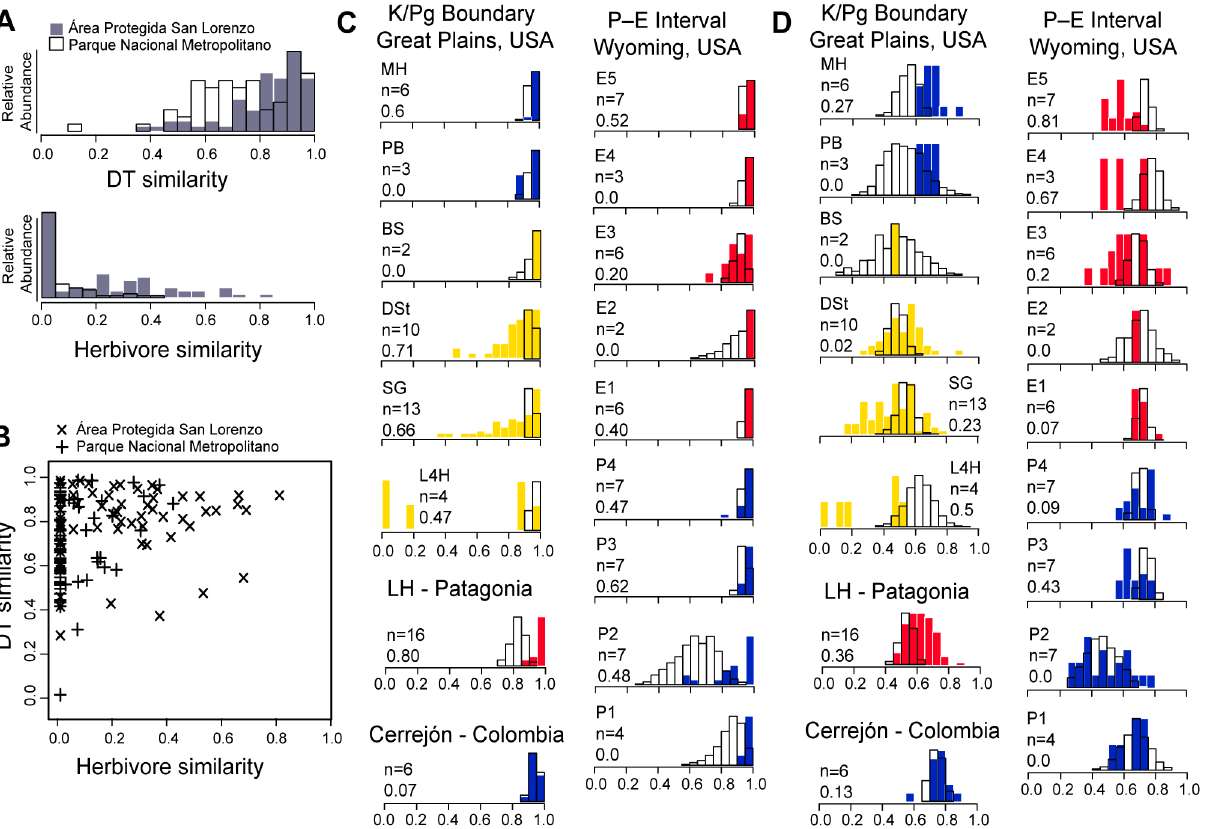
Figure 3. Pairwise host-plant similarities based on herbivores and leaf damage in living forests, and on leaf damage in fossil forests. ( A ) Inverse relations between the distributions of pairwise similarities of leaf damage (DT) and herbivore species, estimated using the Chao- Sørensen index, for host-plant species pairs at the A´rea Protegida de San Lorenzo (gray bars) and Parque Natural Metropolitano (hollow bars), Panama´ (Dataset S1). Vertical axis indicates relative abundance of species pairs showing a given similarity index (horizontal axis). Similarity of DTs between host-plant pairs is much higher than similarity of herbivores, as expected from convergence. ( B ) Plant-species pairwise similarities of herbivores and leaf damage, from the Panama´ crane sites (same as in A ). ( C ) Skewed distributions of host-plant pairwise similarities of leaf-chewing damage at fossil sites (see Materials and Methods), estimated for (n) species at each fossil site, using the Chao-Sørensen index (Dataset S1). Axes are similar to those in ( A ). Yellow = Late Cretaceous, blue = Paleocene, and red = Eocene age. Hollow bars represent distributions of the null expectation, and numbers indicate how many host-plant species (n) and the proportion of observed pairwise estimates that fall outside the null distribution range. ( D ) Distributions of host-plant pairwise similarities of total leaf damage (i.e., including endophytic, largely specialized feeding such as mines and galls) at fossil sites as in (C), estimated as 1-Sørensen coefficient (Dataset S1). There is greatly increased distinctiveness in damage type composition between host plants when endophytic feeding is considered when compared to ( C ).